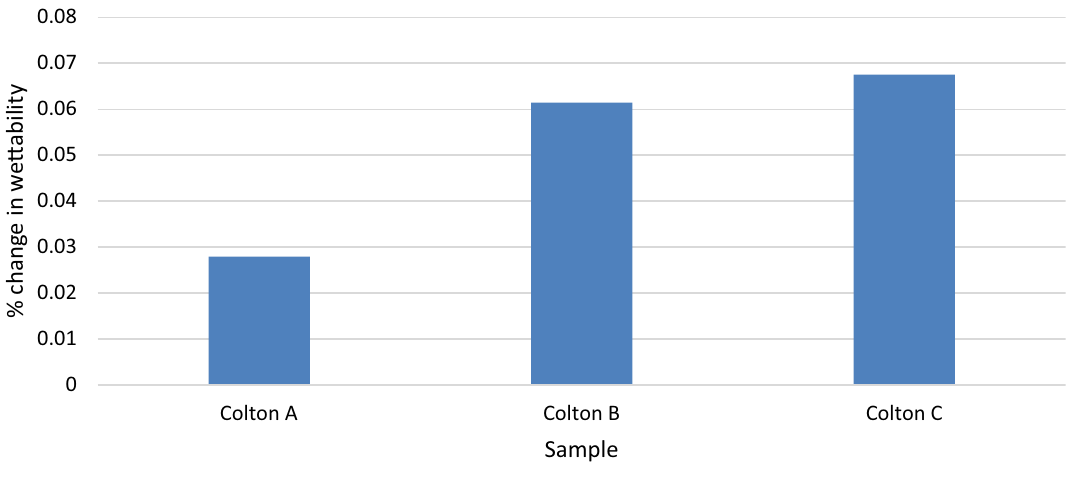
Fig. 8 Wettability changes in Colton sandstone after acidizing